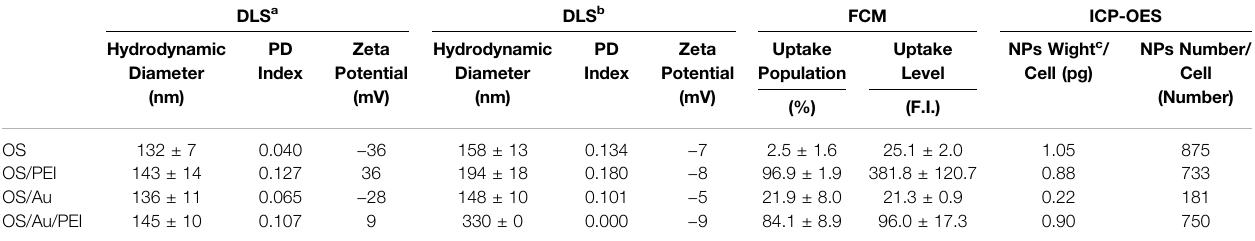
TABLE 1 | Hydrodynamic diameters and zeta potentials of NPs by DLS measurement and the evaluation of cellular uptake of NPs by FCM and ICP-OES measurements. DLS a DLS b FCM ICP-OES Hydrodynamic Diameter